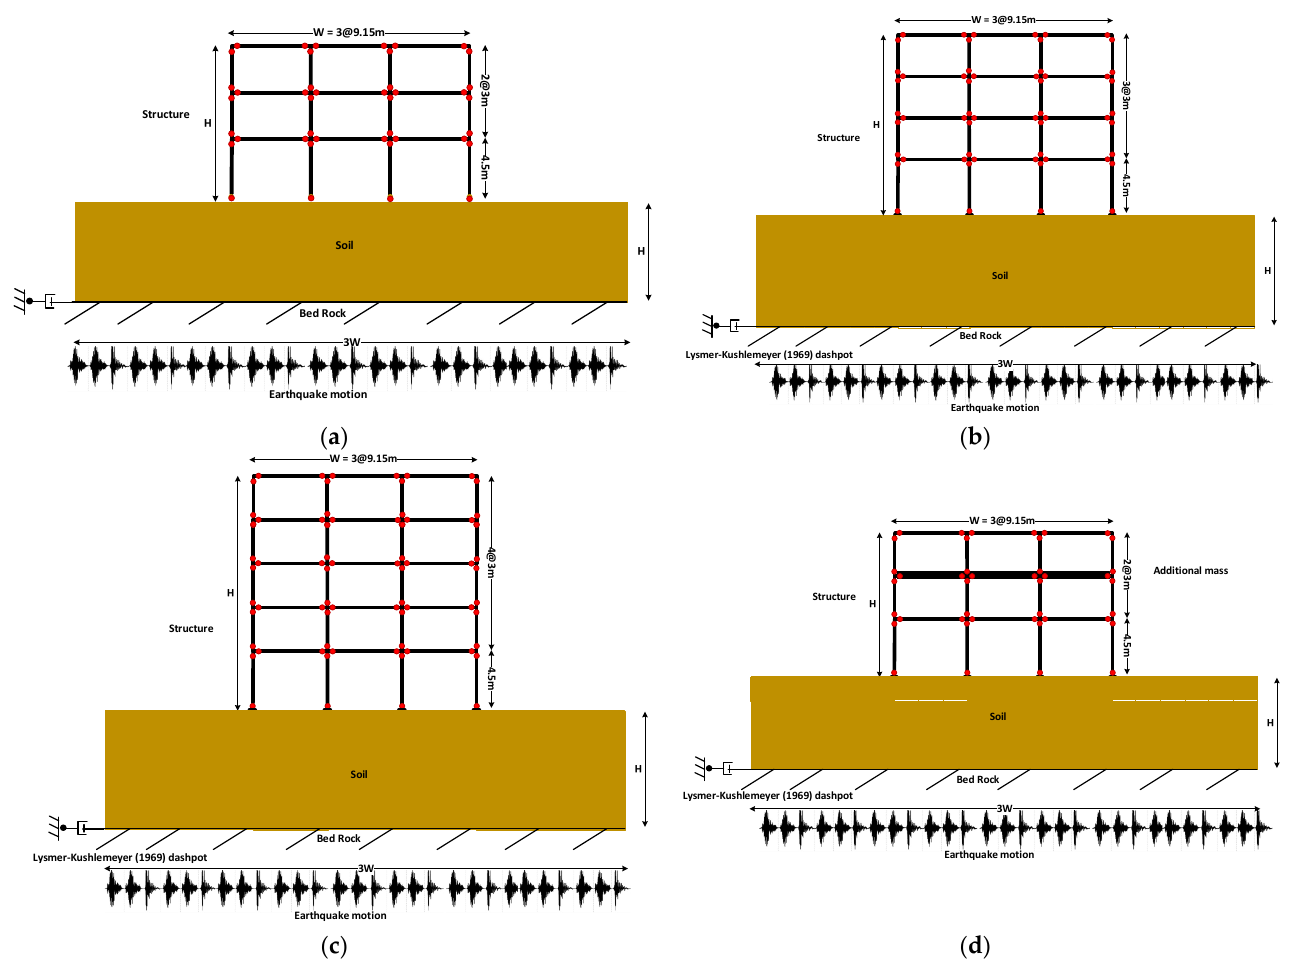
Figure 2. The frame structure models with the soil domain and ground motion. ( a ) Model of the three-story structure. ( b ) Model of the four-story structure. ( c ) Model of the five-story structure ( d ) Model of the three-story mass irregularity